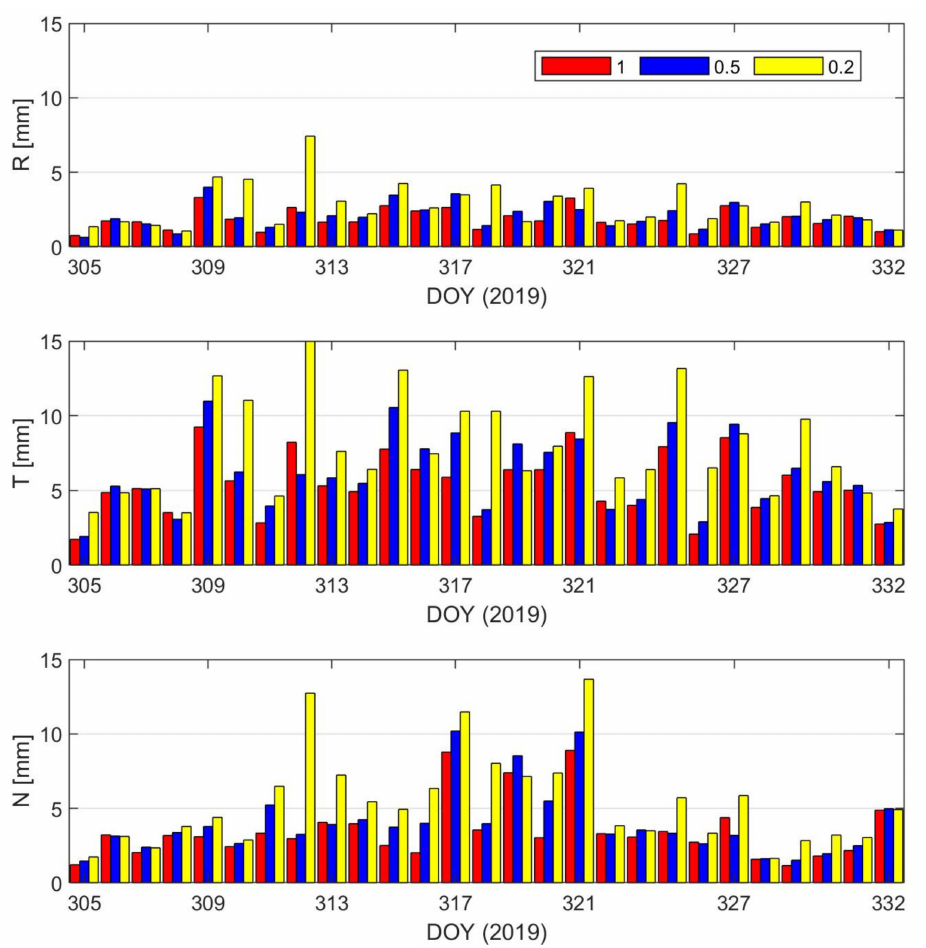
Figure 8. Difference between the GPS-based and BDS2-based PROD with different weights of GEOs (excluding maneuver periods). Considering that BDS2 is a regional constellation, the difference in the accuracy of PROD in different regions needs to be analyzed. The spatial distribution of difference between the GPS-based and BDS2-based PROD in 3D is presented in Figure 9, the mean 3D accuracy of each 5 ◦ × 5 ◦ zone was calculated. The accuracies of BDS2-based PROD in different regions were apparently different. The Asia-Pacific region was defined as longitudes from 55 ◦ E to 180 ◦ E and latitudes from 55 ◦ S to 55 ◦ N. The RMS values of difference between the GPS-based and BDS2-based PROD in the Asia-Pacific region and non-Asia-Pacific region were 2.89 mm and 7.96 mm, respectively. The results are basically consistent with Liu et al. [15]. There were some arcs with large residuals in Figure 7,